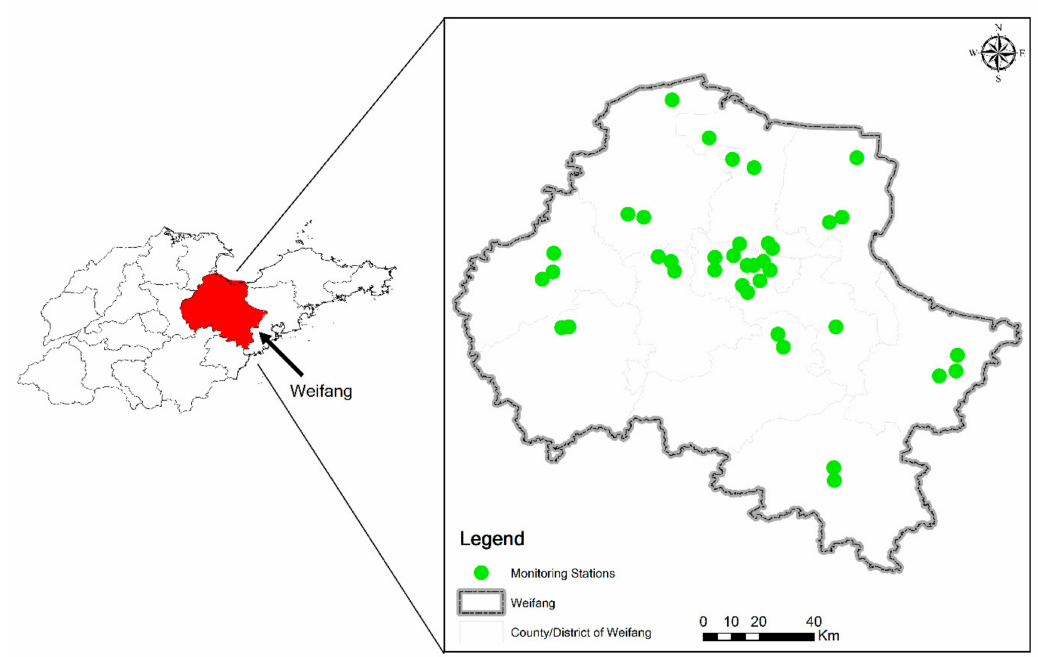
Figure 1. Study area and spatial distribution of the 38 monitoring stations in